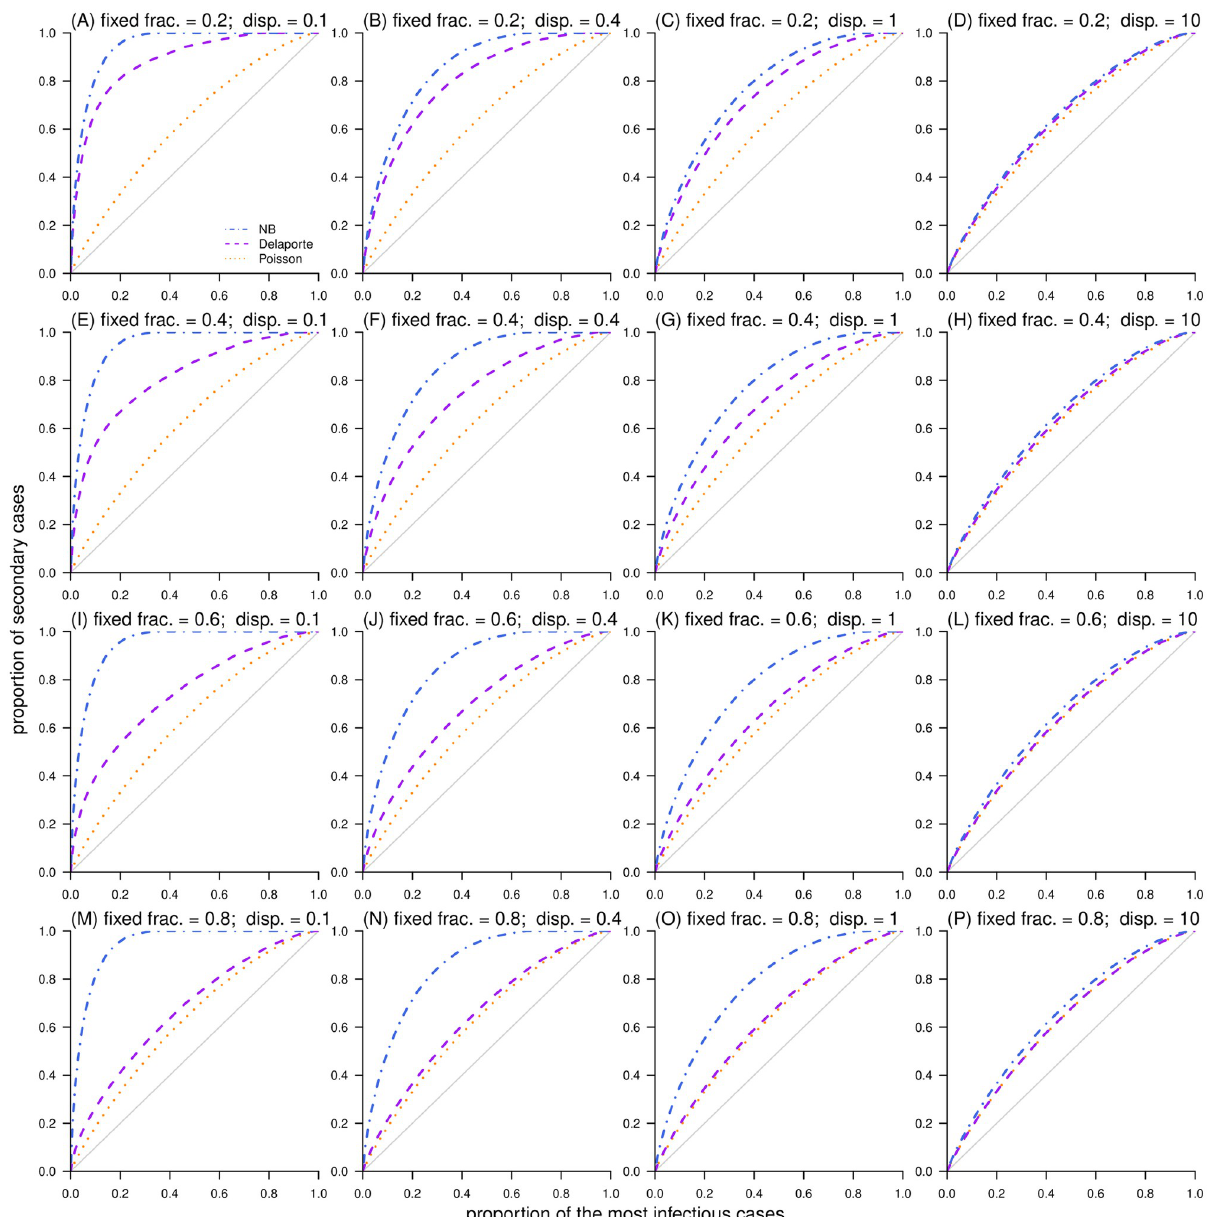
Fig 4. Simulation results of the expected proportion of secondary cases ( Q ) due to the proportion of the most infectious cases ( P ), i.e., Lorenz curve, generated from Poisson (in orange), negative binomial (in blue), and Delaporte (in purple) distributions. In each panel, the diagonal line shows the scenario of perfect homogeneity (i.e., uniform distribution). In each panel label, ‘fixed frac.’ is the fraction of fixed component ( ρ ), and ‘disp.’ is the dispersion parameter ( k